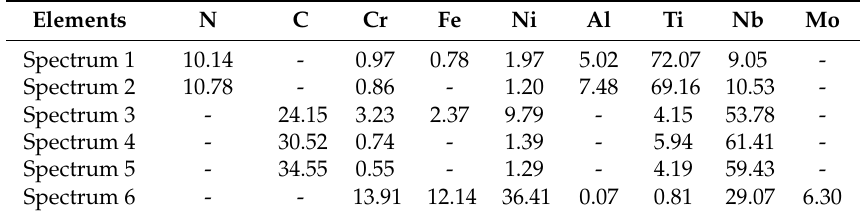
Table 3. EDS results from spectrums marked in the FESEM images (wt